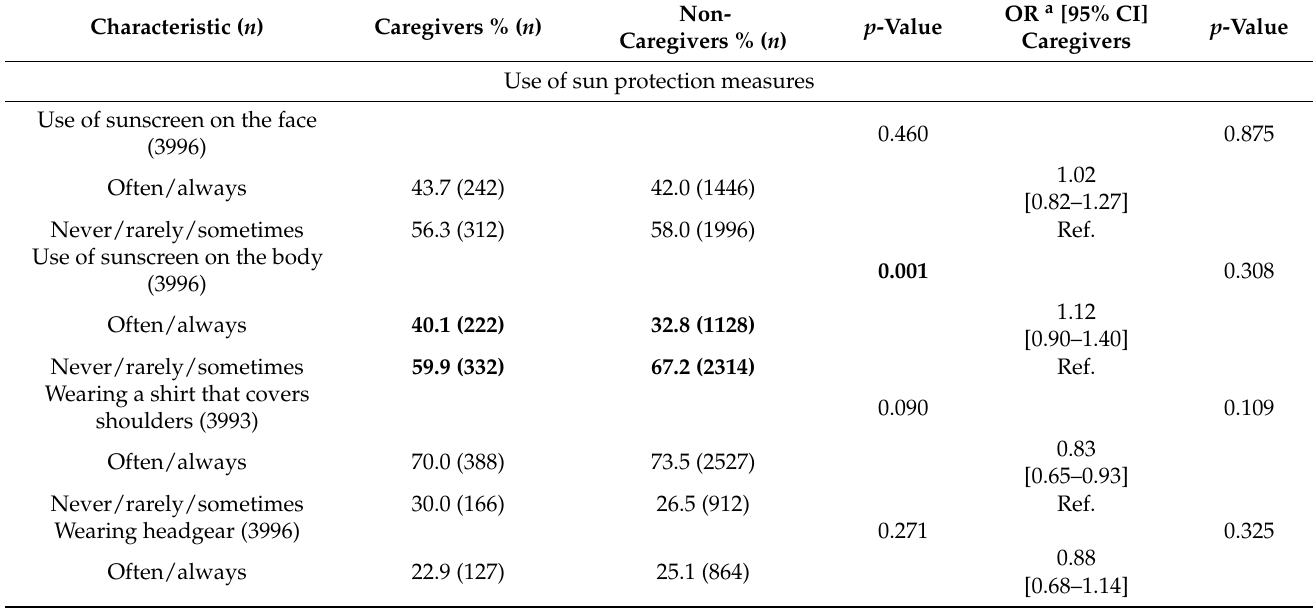
Table 2. Sun protection and tanning behaviors in caregivers compared to